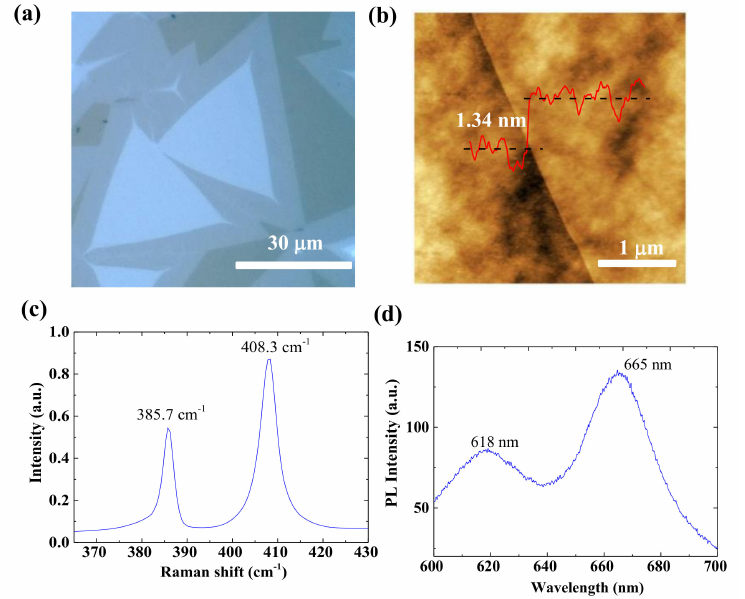
Figure 1. ( a ) Optical micrograph of chemical vapor deposition (CVD) bilayer MoS 2 on molten glass. ( b ) Atomic force microscopy image of bilayer MoS 2 on SiO 2 /Si substrates after transfer. Raman ( c ) and photoluminescence (PL) spectra ( d ) of high-quality CVD bilayer MoS 2